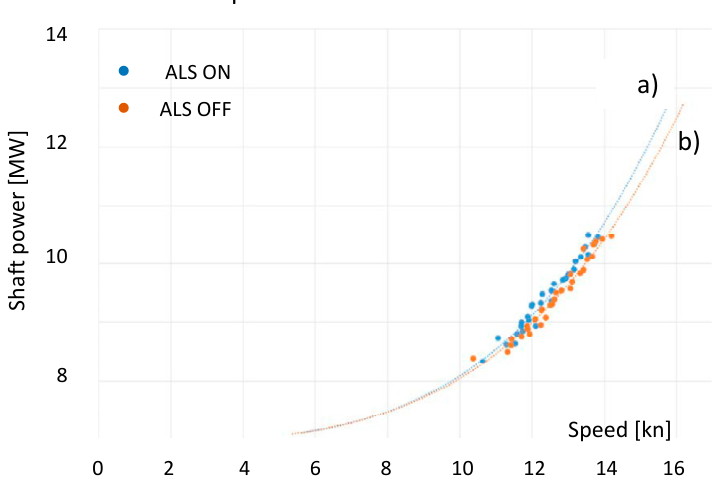
Figure 7. Average Shaft Power for given RPM (Revolution Per Minute) against Speed from MT Amalienborg [26]. The propeller curve for ON and OFF ALS system presented in the diagram P=f(v) shows the benefits of this system operation in the form of lower demand for propulsion power at the same ship speed. This is evidenced by the shift of the propeller curve (a) towards the so-called lighter propeller curve (b).